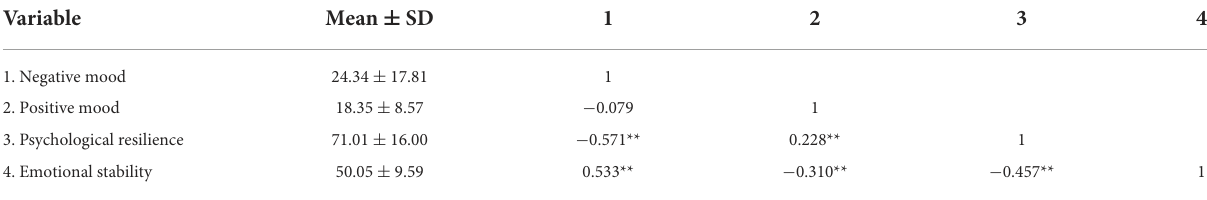
TABLE 1 Descriptive statistics and correlation analysis of negative mood, positive mood, psychological resilience, and emotional stability ( N = 360). Variable